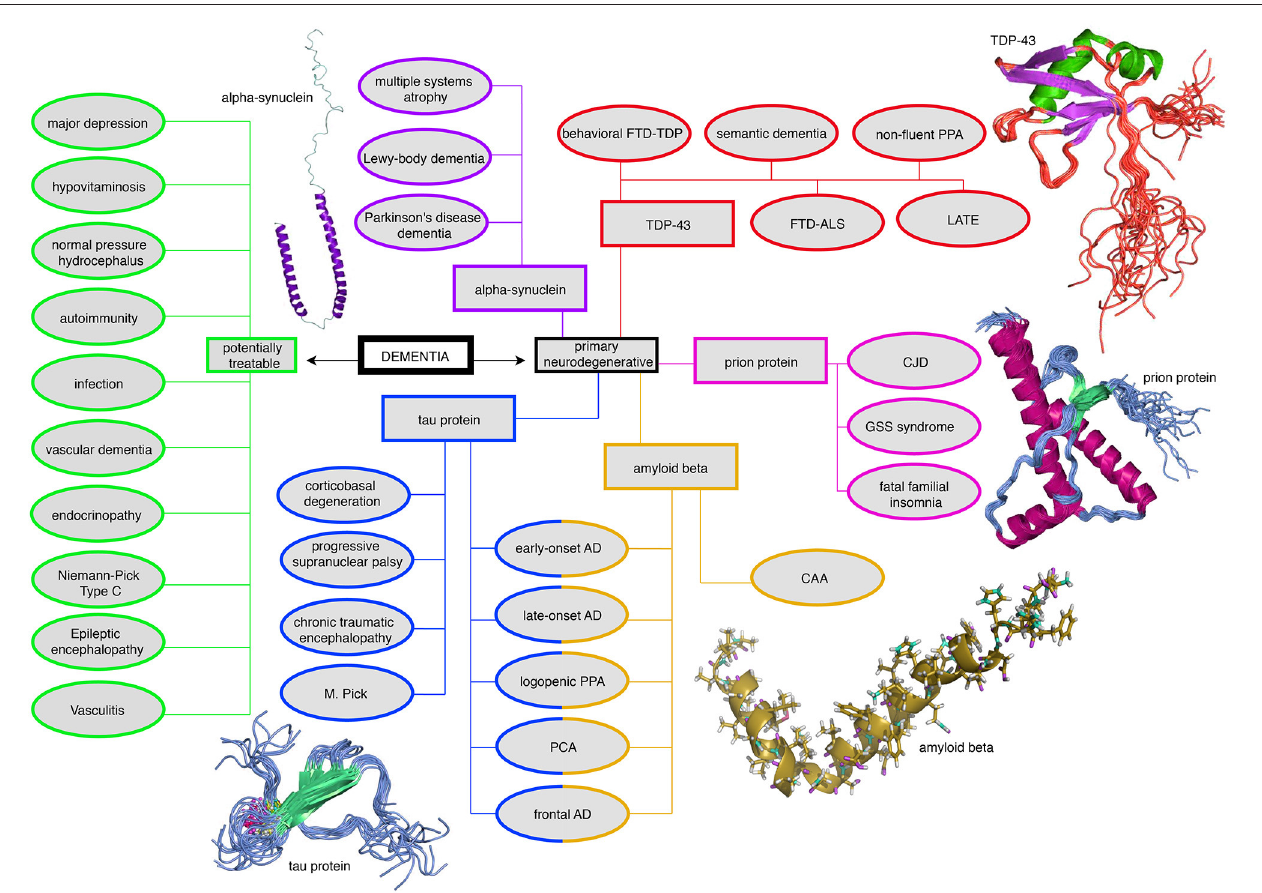
FIGURE 3 | Mind map of the dementia syndrome and its differential diagnoses. The possible etiologies are widely spread across cerebral and systemic diseases. It is important to mention that Alzheimer’s Disease (AD) is the most common form of dementia, but AD is not trivial to diagnose, in particular, if it requires to forgo some invasive tests in the elderly. However, the exact diagnosis is of enormous relevance because some possible causes of dementia are curable, such as normal pressure hydrocephalus, metabolic disorders, and immunologic or infectious causes. In the clinic, most patients are diagnosed with AD, vascular dementia, Lewy-body dementia, frontotemporal dementia, or a mixed form thereof ( Figure 2 ). None of the primary neurodegenerative diseases can be treated in a causal and disease-modifying way, besides the treatment of vascular dementia with general atherosclerosis therapy. Their leading proteinopathy sorts the neurodegenerative diseases—caused by Abeta, Tau, prion protein, transactive response DNA binding protein 43 kDa ( TDP-43 ), and alpha-synuclein ( Wallesch and Förstl, 2012). Protein images modified from http://www.ebi.ac.uk/. FTD-TDP, frontotemporal degeneration caused by TDP-43 ; PPA, primary progressive aphasia; FTD-ALS, frontotemporal degeneration with amyotrophic lateral sclerosis; LATE, limbic-predominant age-related TDP-43 encephalopathy; CJD, Creutzfeldt-Jakob’s disease; GSS, Gerstmann-Sträußler-Scheinker (syndrome); CAA, cerebral amyloid angiopathy; PCA, posterior cortical atrophy; M. Pick, Pick’s